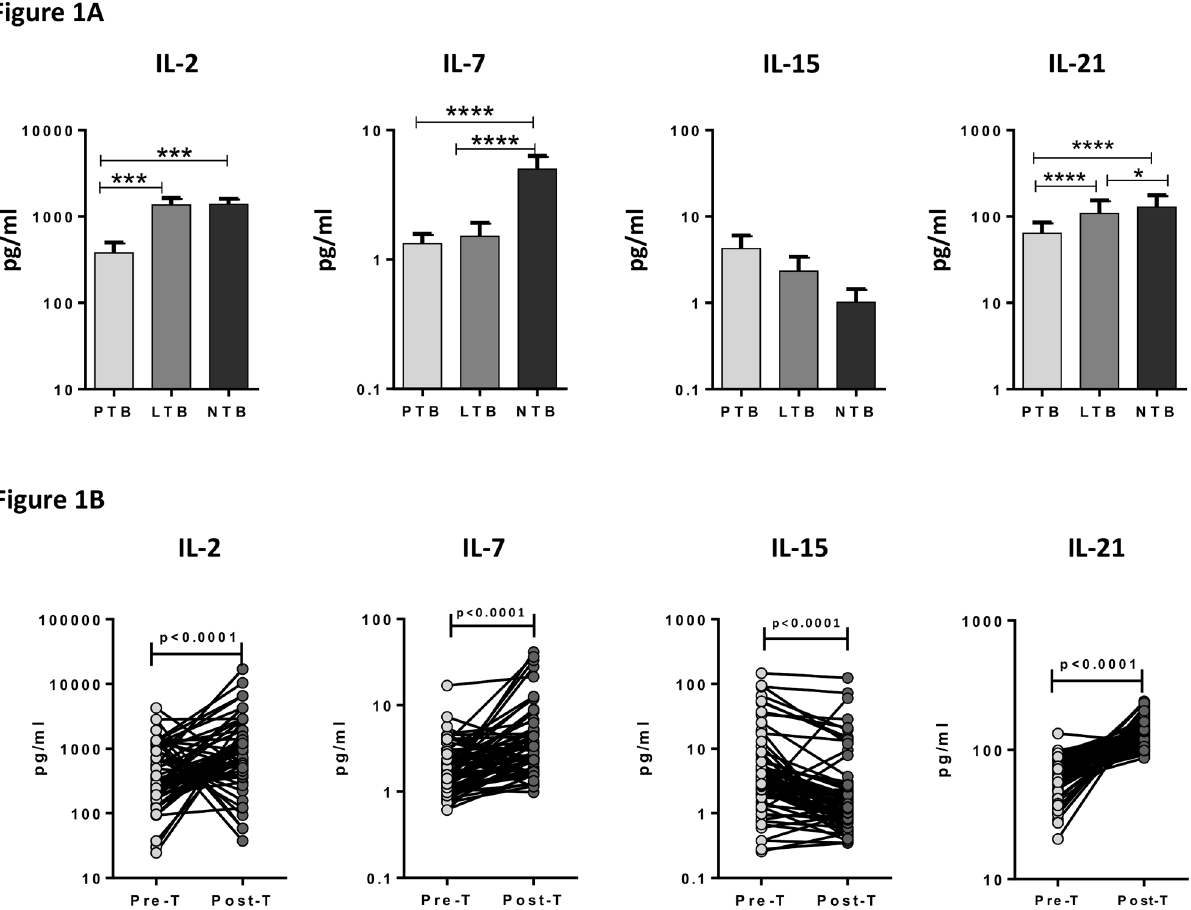
Fig 1. Diminished systemiclevels of circulating common γ -chain cytokines in PTB individuals and restoration following anti-TB treatment. (A) The plasma levels of common γ -chaincytokines IL-2, IL-7, IL-15 and IL-2 were measuredin PTB (n = 66), LTB (n = 66) and NTB (n = 66) individuals.The data are representedas bar graphs showinggeometric means and 95% confidenceintervals. P values were calculatedusing the Kruskal-Wallis test with Dunn’spost hoc comparison. (B) The plasma levels of common γ -chain cytokines IL-2, IL-7, IL- 15 and IL-2 were measuredin PTB individuals before (pre-T) and after (post-T) standardanti-tuberculosis chemotherapy. The data are representedas line graphswith each line representinga single individual. P values were calculatedusing the Wilcoxon signed rank